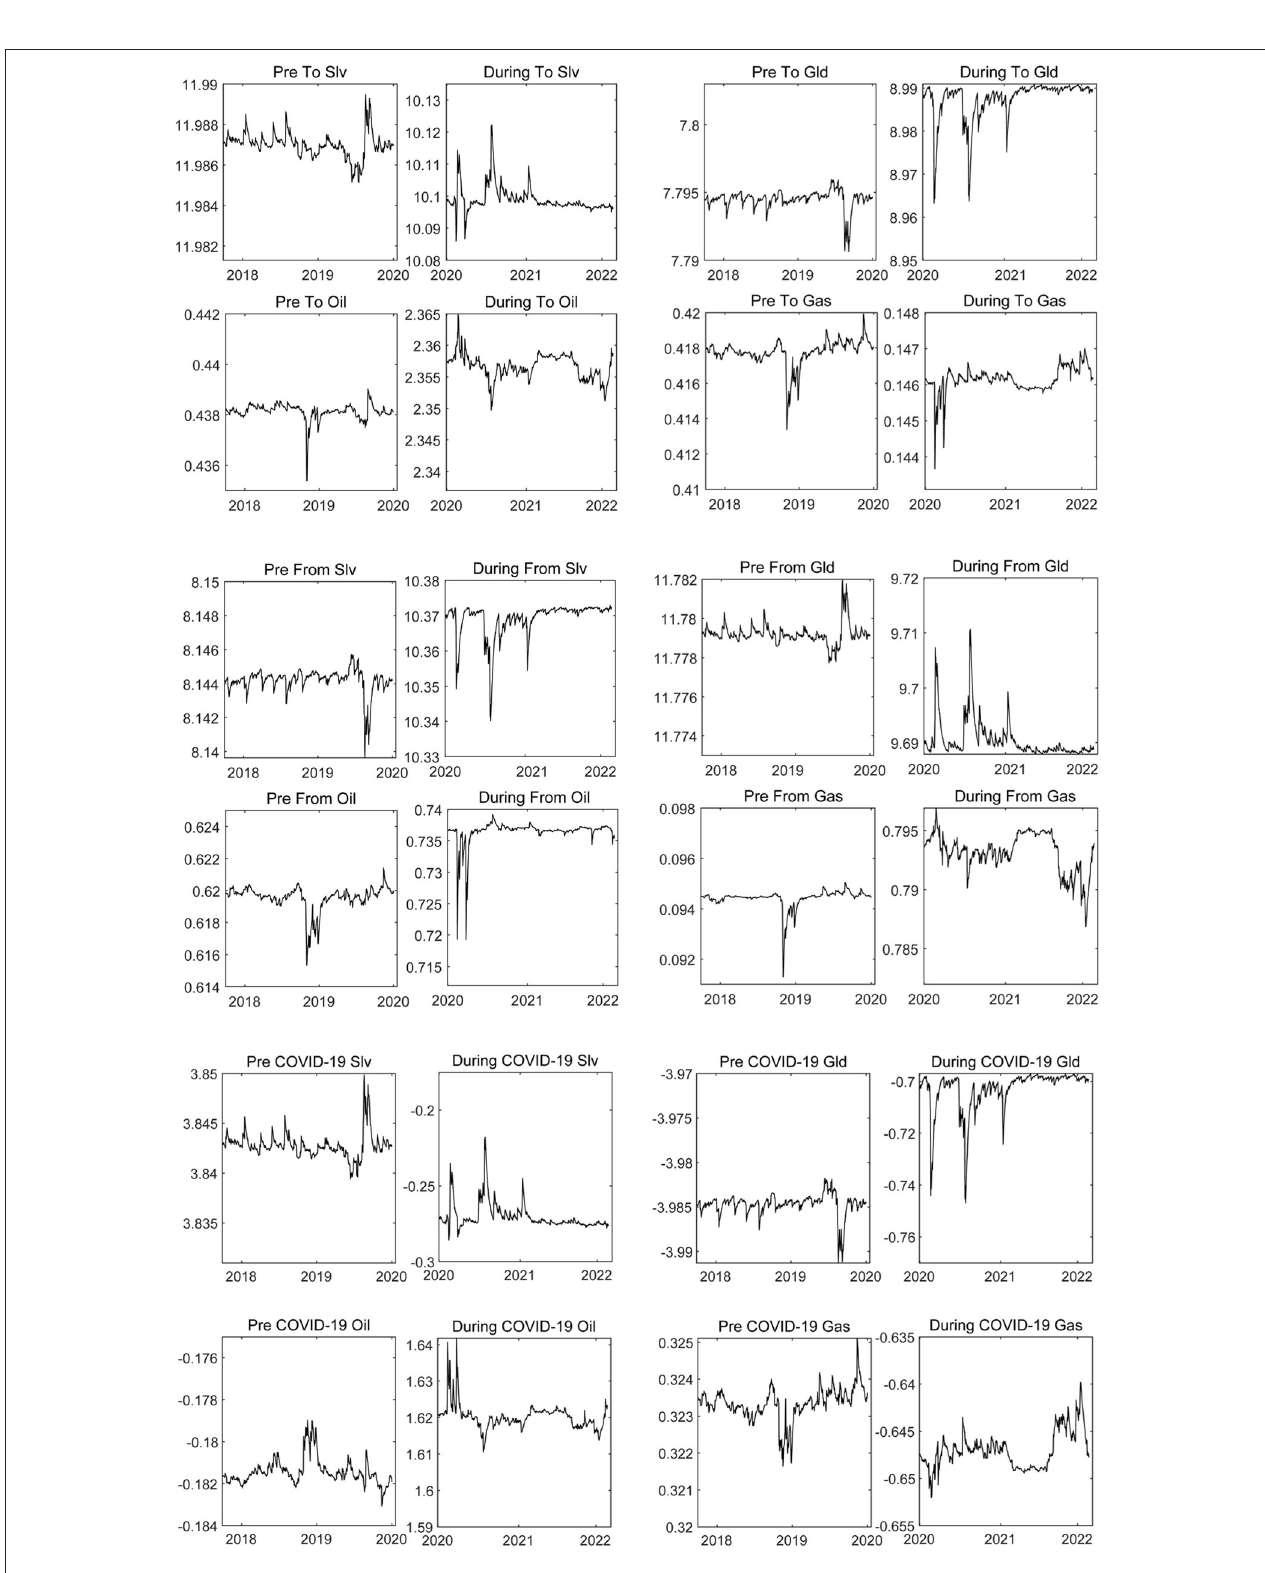
FIGURE 3 | The time-varying directional connectedness of the energy and precious metals markets. The results are based on the DCC-GARCH-CONNECTEDNESS approach, and the solid line represents the change trend of the “TO volatility spillover,” “FROM volatility spillover” and “NET volatility spillover” of energy and precious metals markets; “Pre” indicates the period before the COVID-19 epidemic, and “During” indicates the COVID-19 epidemic period.